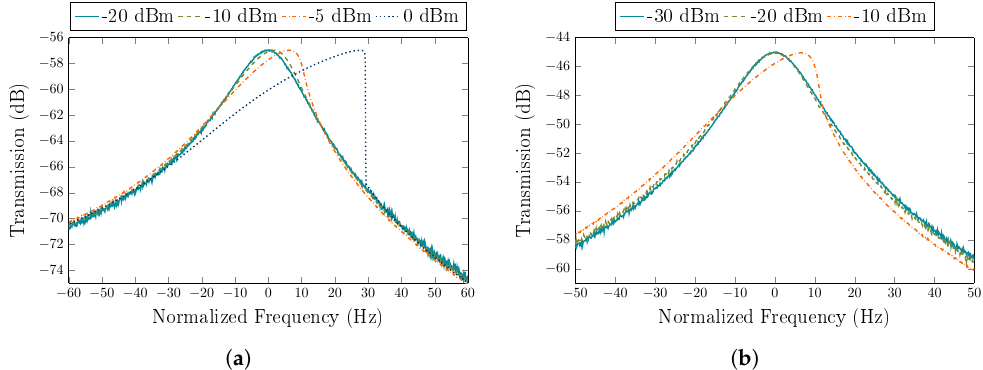
Figure 7. Normalized resonator transmission characteristic curves for various output input amplitude levels for ( a ) V p = 100V and ( b ) V p =